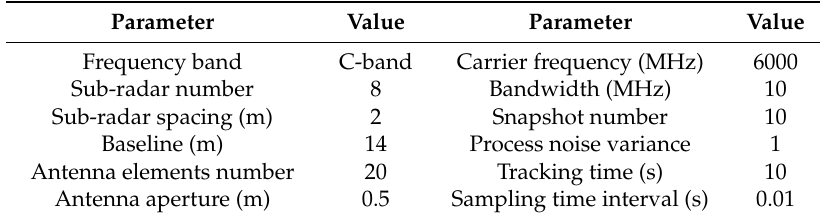
Figure 1. Diagram of the simulation scenario. Table 2. Simulation